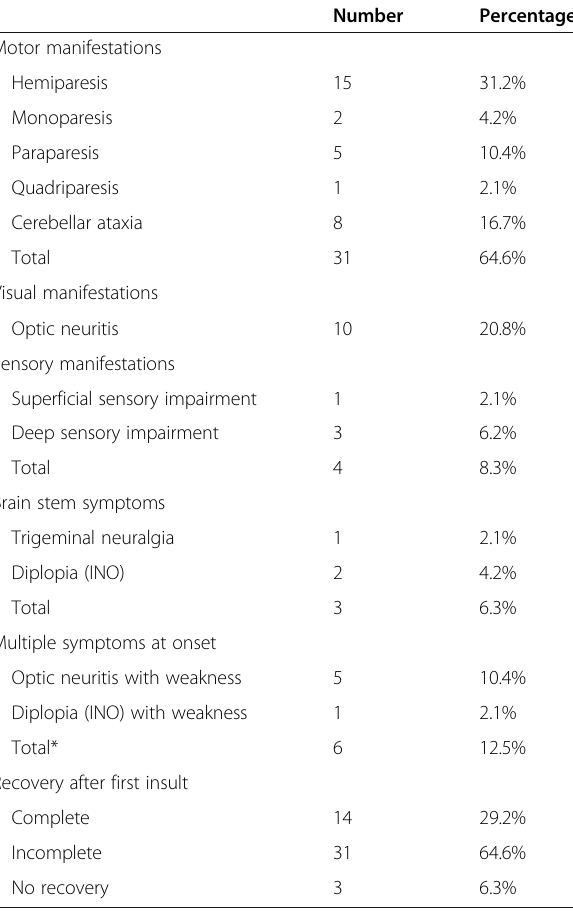
Table 1 Clinical manifestations of initial presentation of MS patients. n , %